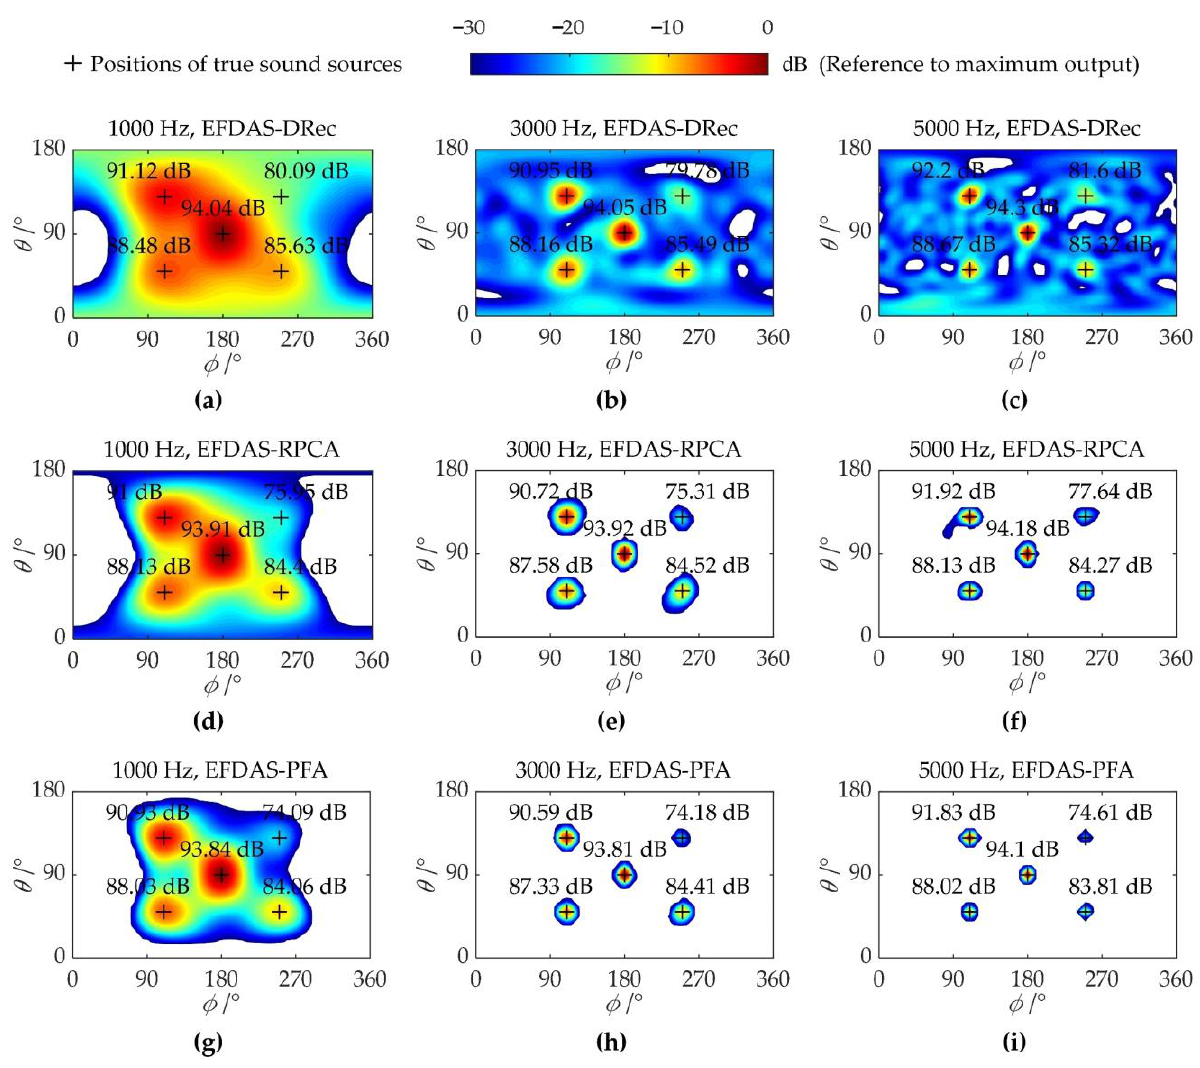
Figure 4. Colormaps of EFDAS with SNR = 0 dB and 1000 snapshots: ( a – c ) Maps of EFDAS-DRec at 1000 Hz, 3000 Hz, and 5000 Hz, respectively; ( d – f ) Maps of EFDAS-RPCA at 1000 Hz, 3000 Hz, and 5000 Hz, respectively; ( g – i ) Maps of EFDAS-PFA at 1000 Hz, 3000 Hz, and 5000 Hz, respectively.